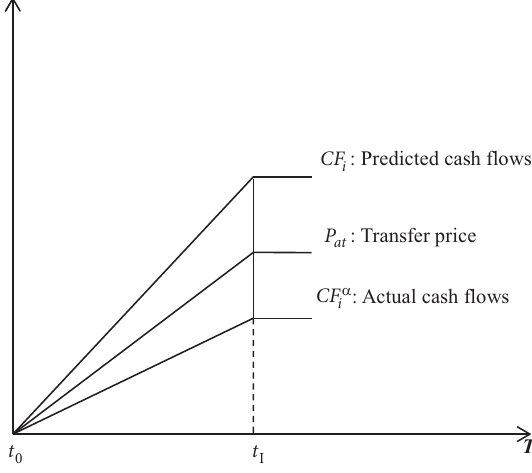
Figure 6. Cash flows for early termination in PPP projects